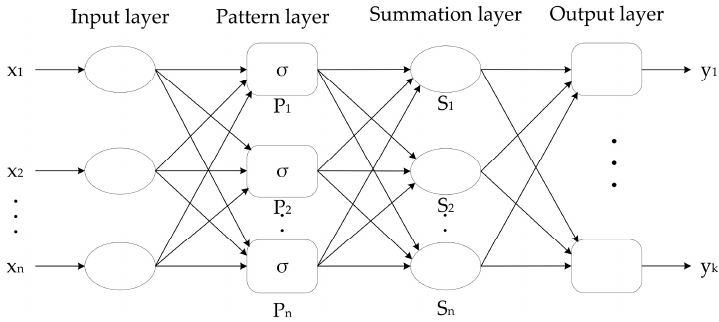
Figure 5. Schematic diagram of the structure of the GA-GRNN surrogate model.